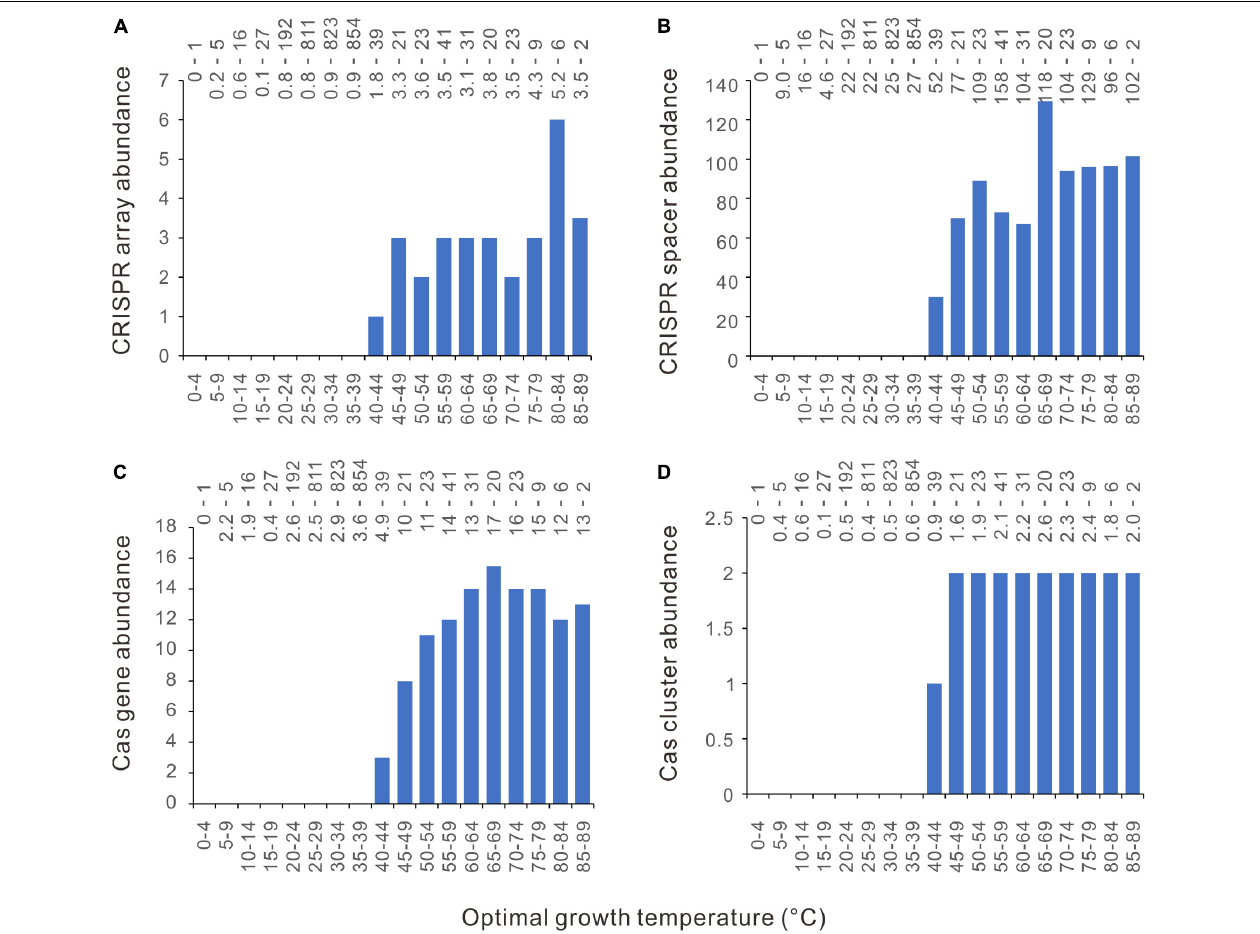
FIGURE 1 | Distinctive relationships of bacterial CRISPR-Cas abundance with different optimal growth temperature (Topt) ranges. The abundances of CRISPR arrays (A) , spacers (B) , cas genes (C) , and cas gene clusters (D) increase substantially with Topt at around 40–45 ◦ C. Because median values are less sensitive to extreme outliers than the mean values, we created the column charts using the median value of each Topt range. The mean value and the number of genomes of each bin (separated by a hyphen) are shown at the top of each chart.